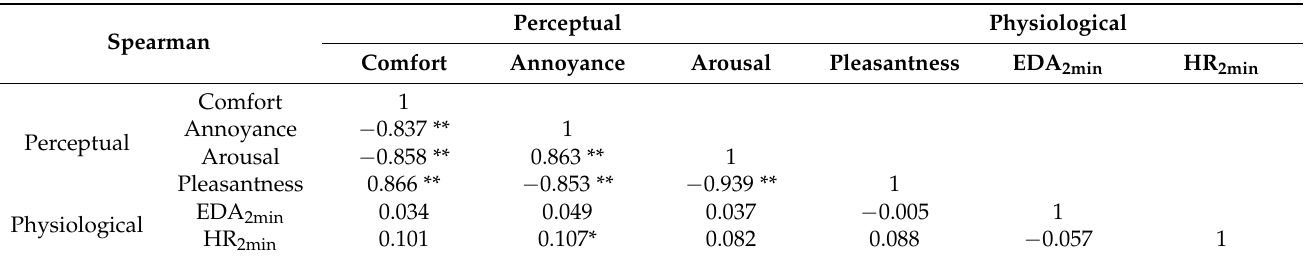
Table 3. Correlation analysis between psychological and physiological responses. * and ** represent significant difference at 0.05 and 0.01 level, respectively.